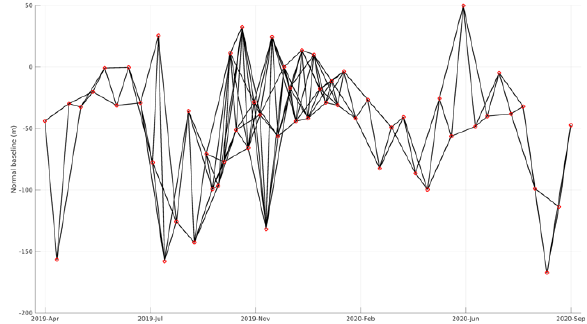
Figure 1 . Sentinel-1 SBAS-InSAR baselines.